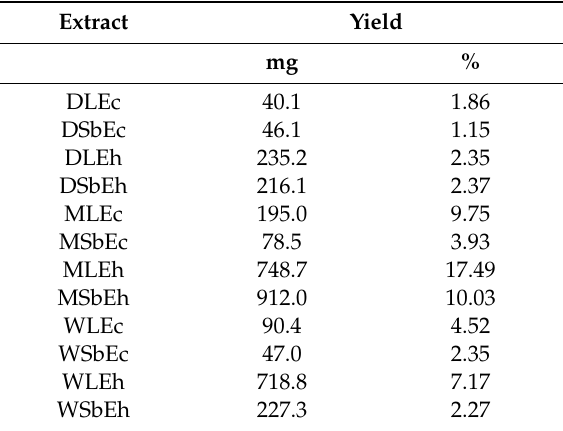
Table 1. Yield of L. barteri leaves and stem bark